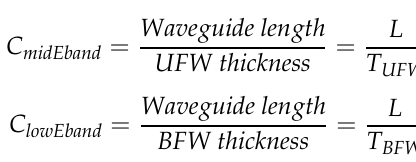
Figure 8. ( a ) Illustration of the simulation structure in association with geometrical parameters. Some representative rays are shown to explain the decoupling loss mechanism. ( b ) Simulation of the total system under the full solar spectrum with ray tracing.